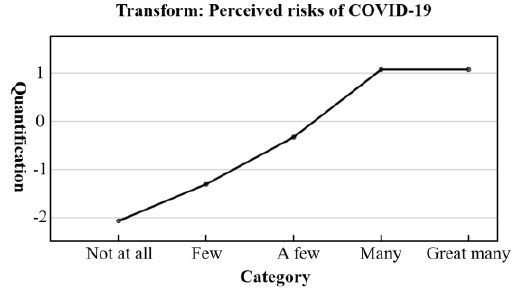
Figure 9. The quantization of the variable of perceived health risk caused by COVID-19.